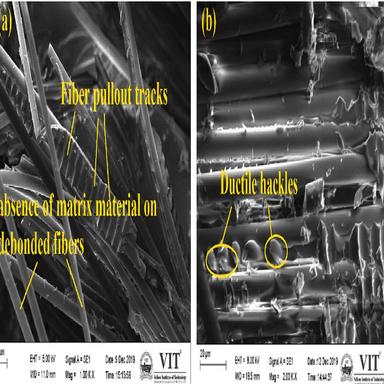
Flexural strength for GFRP composites with various wt% of graphene.